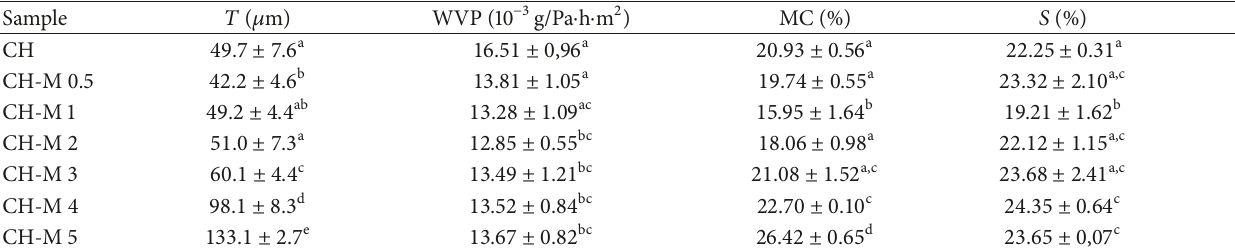
Table 5: Physical properties of chitosan films with the marjoram essential